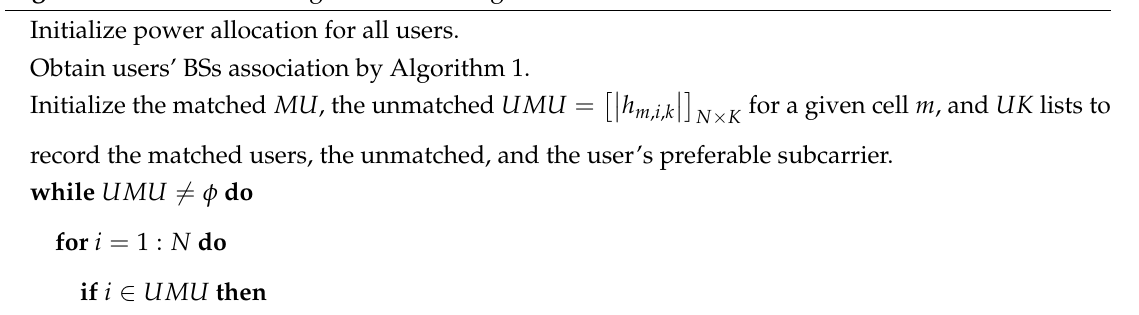
Algorithm 2 Subcarrier assignment matching